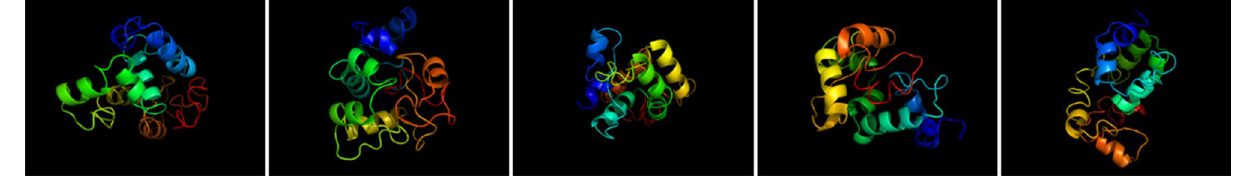
Figure 5. 3D structures prediction of leish21 by using QUARK